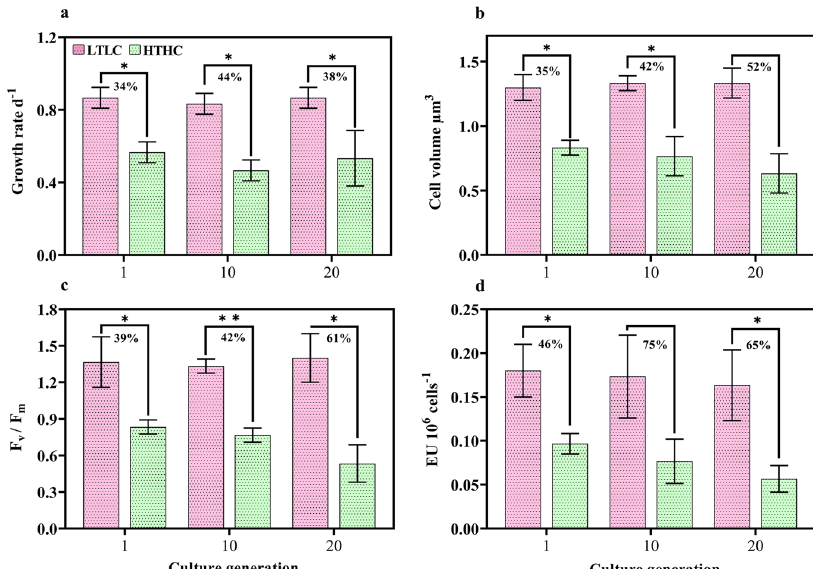
Fig. 1 Physiological response of Heterosigma akashiwo grown to different generations under LTLC and HTHC conditions. a Speci fi c growth rate ( b ) Cell volume, ( c ) photochemical yield, and ( d ) carbonic anhydrase activity. Vertical bars in each graph represent triplicate samples (SD, n = 3). The percentage indicates comparison values between the LTLC and HTHC samples. Signi fi cant differences for each parameter relative to the control are denoted by ∗ p < 0.05 and ∗∗ p < 0.001.